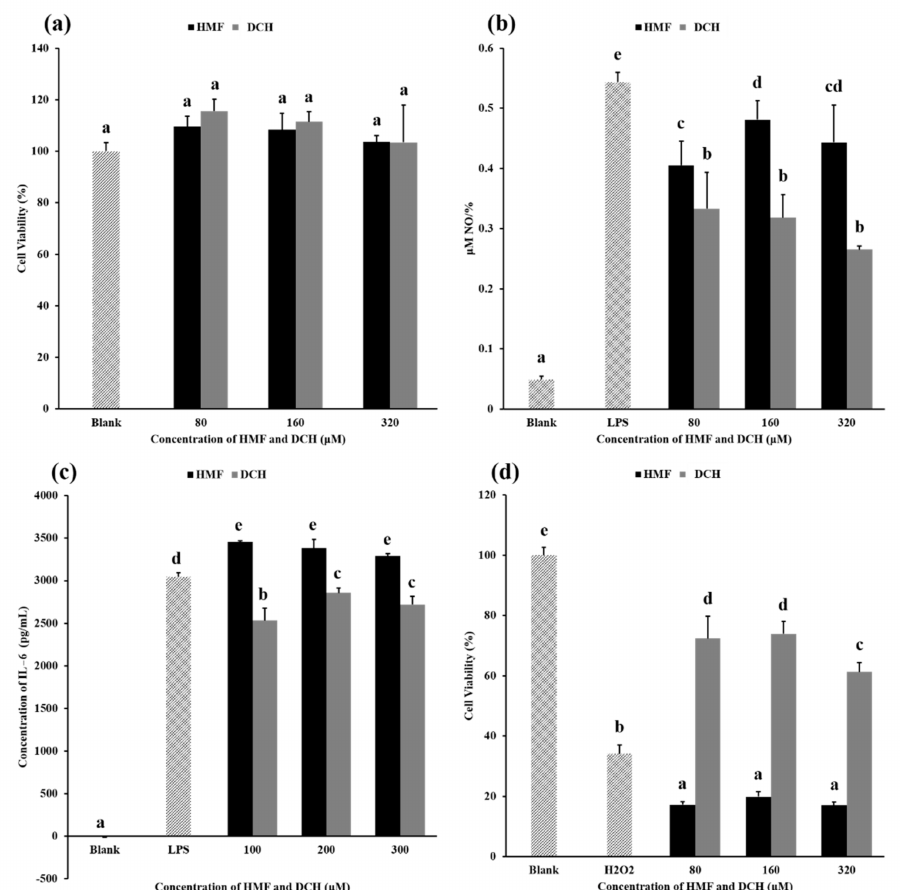
Figure 4. Comparison of biological activity between HMF and DCH. ( a ) The influence of HMF and DCH on the viability of RAW 264.7 cells. ( b ) Effect of HMF and DCH on the Nitric oxide (NO) production in LPS-stimulated RAW 264.7 cells. ( c ) Effects of HMF and DCH on the secreted protein levels of IL-6 in RAW 264.7 cells. ( d ) Cell viability after oxidative damage induced by hydrogen peroxide. Different letters indicate significant differences, p <